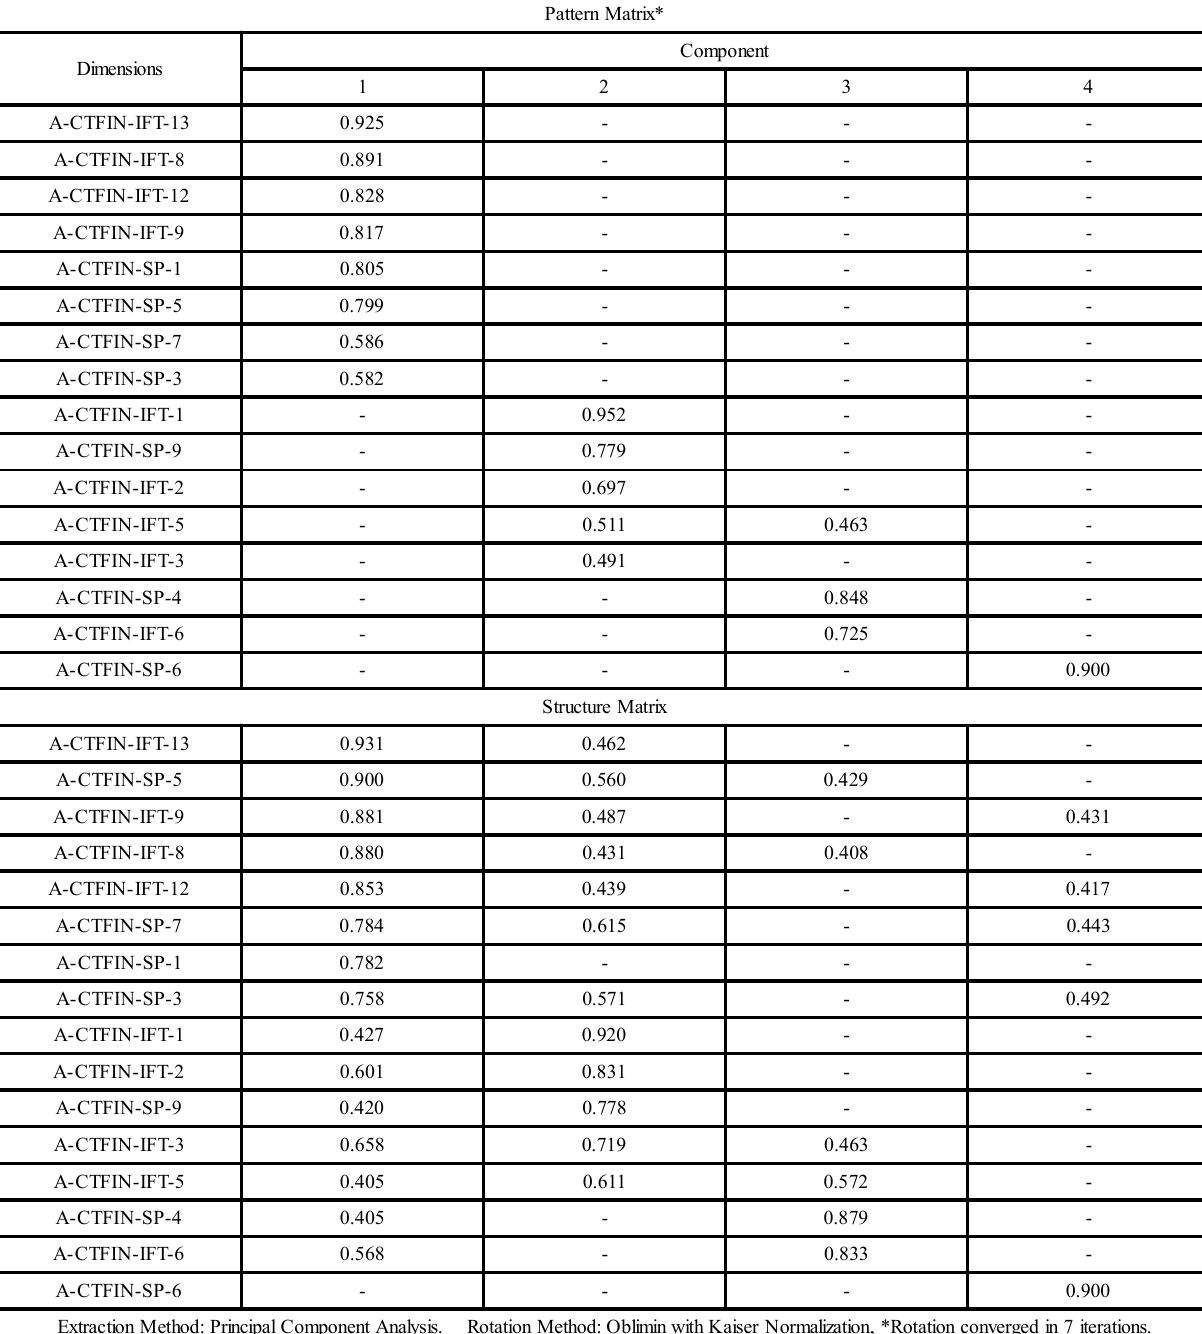
TABLE 12. DETAILS OF FACTOR EXTRACTION (OBLIQUE ROTATION WITH FOUR